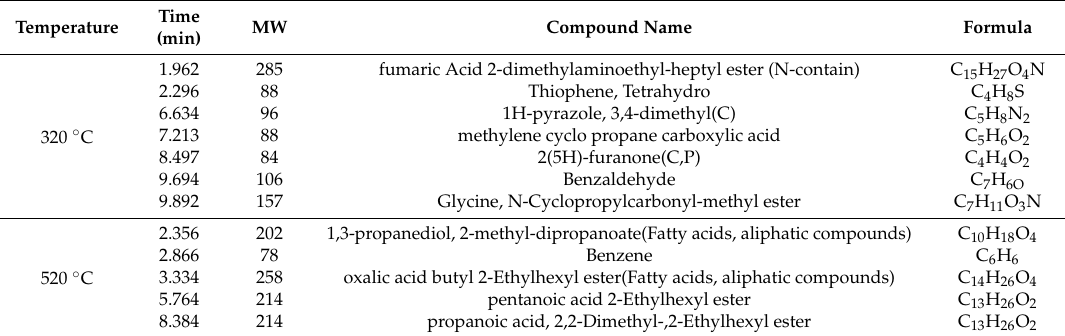
Table 4. TGA-GC-MS analysis results for